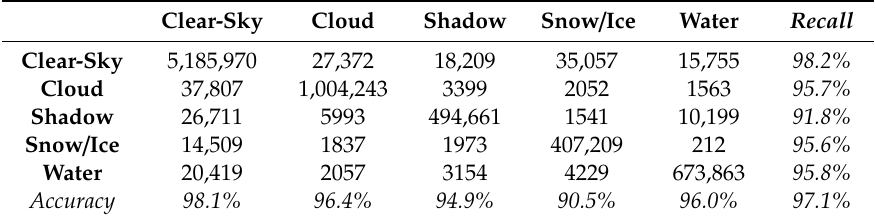
Table 1. Agreement between the CNN Spatial Procedures for Automated Removal of Cloud and Shadow (SPARCS) method described in this paper and the manually labeled imagery across all eight evaluation scenes, with class-wise accuracy and recall statistics (italics).